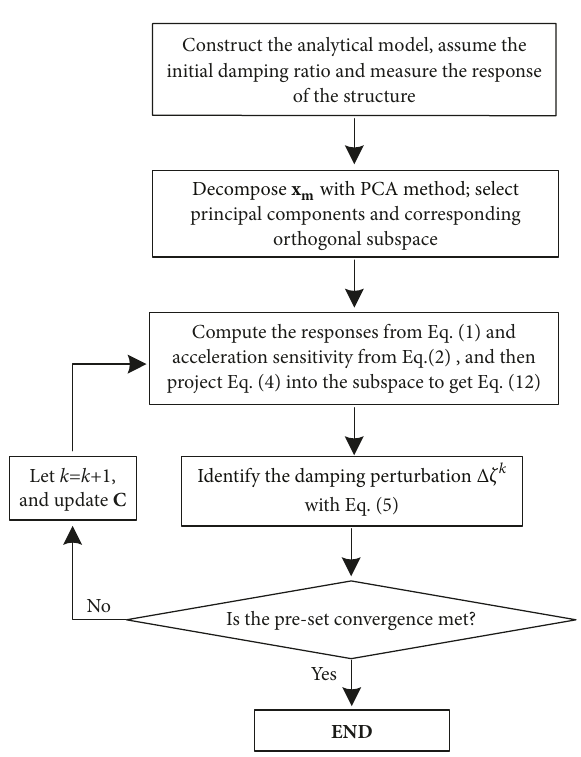
Figure 1: The flowchart of the proposed damping identification method.